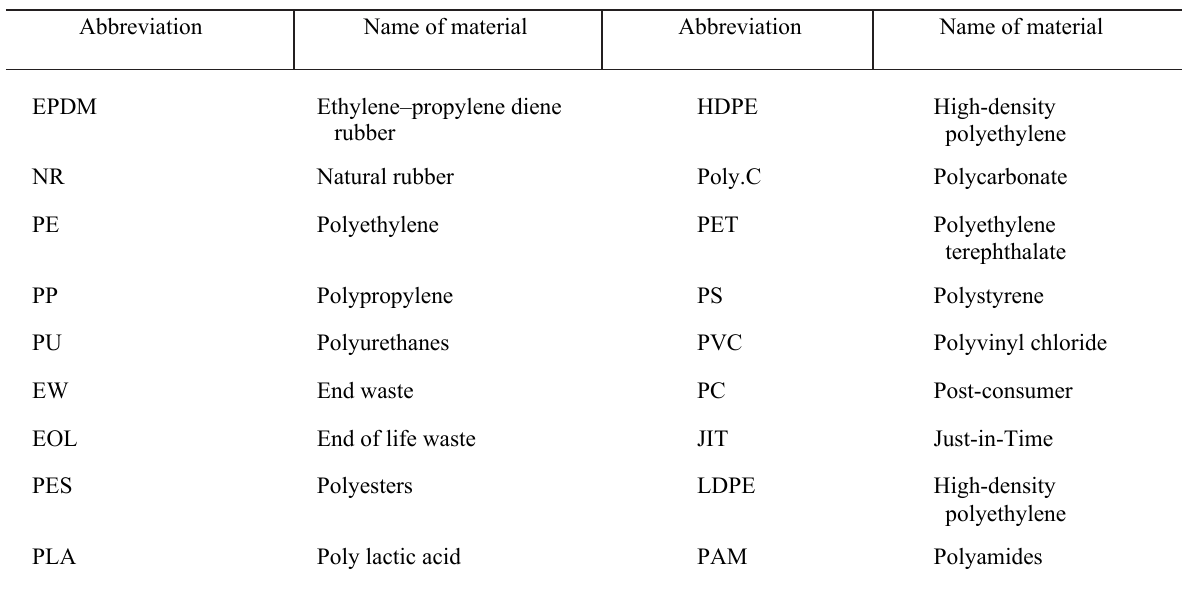
Table 3. Terminology and abbreviations of textile